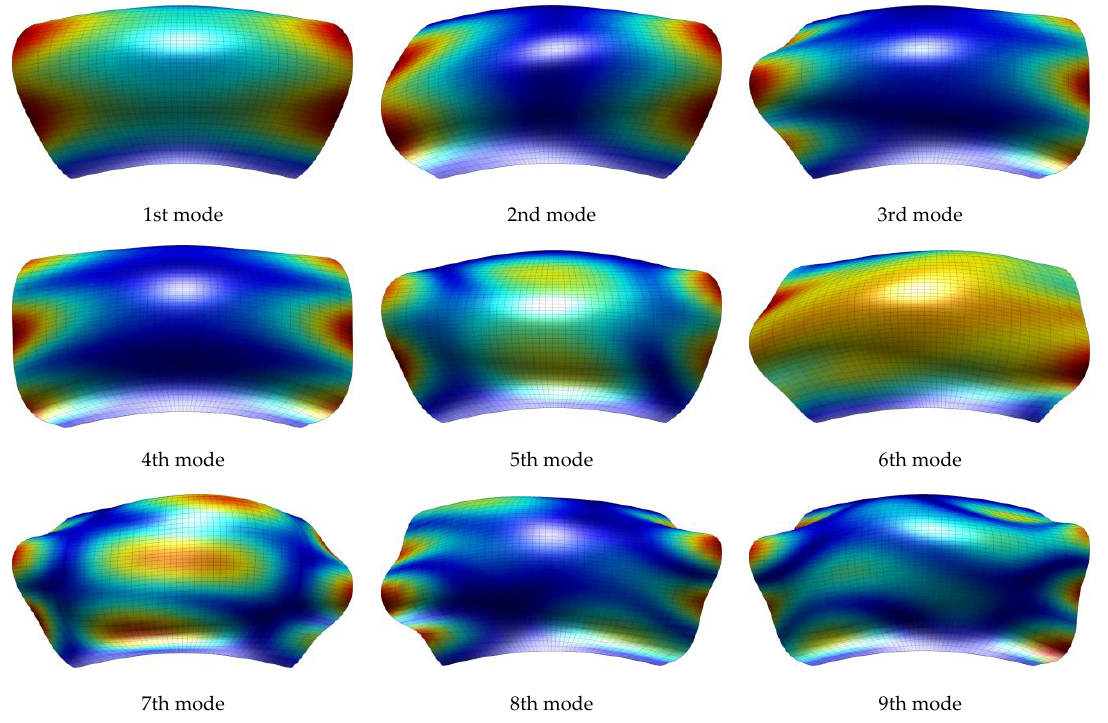
Figure 7. First nine mode shapes for a CFCF laminated panel of translation with ( 0/30/60/90 ) as lamination scheme.